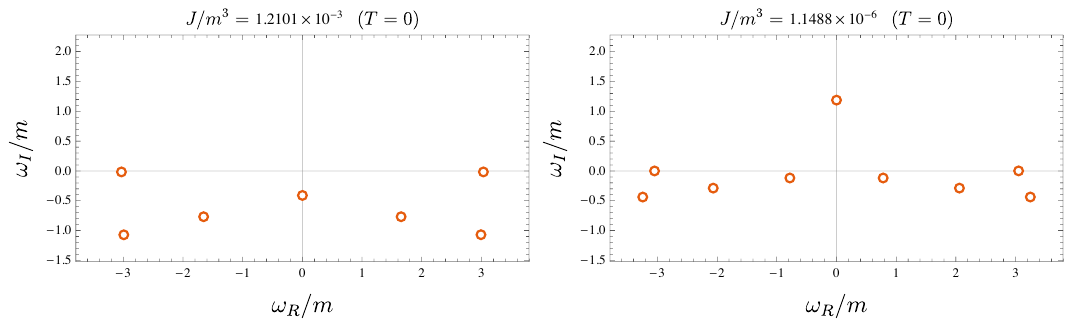
Figure 7 . Frequencies of the QNMs on the complex plane of ω = ω R + iω I for some J/m 3 ; the left panel shows J/m 3 = 1 . 2101 × 10 − 3 on the upper branch and the right panel shows J/m 3 = 1 . 1488 × 10 − 6 on the lower